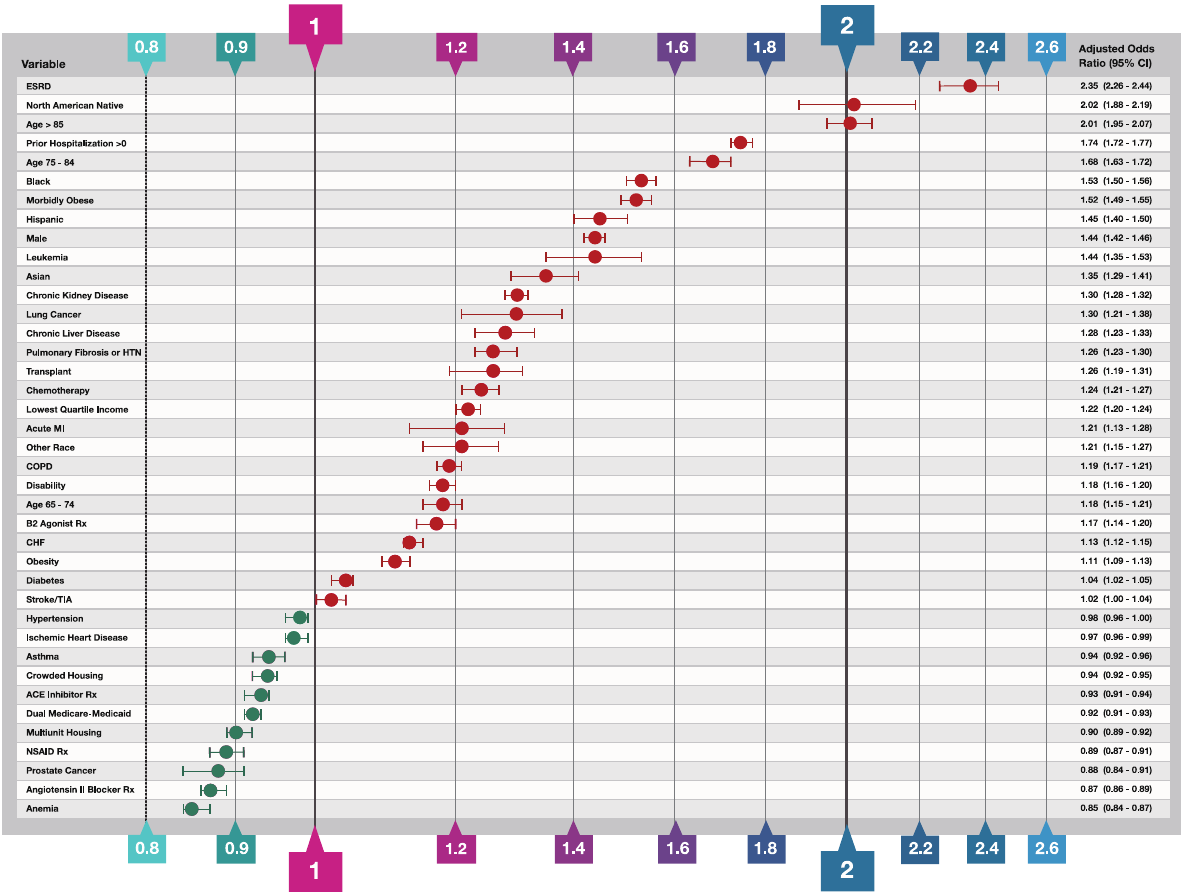
Figure 1. Predictor Variables for COVID-19-Related Hospitalization. The independent variable odds ratios were determined by binary logistic regression analysis of confirmed COVID-19 cases that required hospitalization for the disease versus those that were managed with outpatient care only. In addition to the thirty-nine variables shown in the figure, the following variables were included in the model and survived the variable selection procedure described in Methods but are not shown: colorectal cancer (OR 1.07; 95% CI 1.01–1.14), endometrial cancer in the second half of 2019 (OR 1.12; 95% CI 1.00–1.25), other ethnicity (OR 1.19; 95% CI 1.13–1.25), unknown ethnicity (OR 0.96; 95% CI 0.91–1.00), prescriptions overlapping the COVID-19 diagnosis date of Azithromycin (OR 1.15; 95% CI 1.11–1.18), Chloroquine and Hydroxychloroquine drugs (OR 0.96; 95% CI 0.91–1.01), anticoagulant drugs (OR 1.06; 95% CI 1.04–1.08), opioid drugs (OR 1.03; 95% CI 1.01–1.05) and H2 blocker drugs (OR 1.03; 95% CI 0.99–1.06); Variables excluded from the model by the variable selection procedure included a history breast cancer in the second half of 2019, prescriptions for immunosuppressive and corticosteroid drugs overlapping the COVID-19 diagnosis date, hypertension and pneumococcal vaccinations. B2 Agonist Rx signifies treatment with a beta-2 bronchodilator drug; NSAID Rx signifies treatment with a Non-Steroidal Anti-Inflammatory